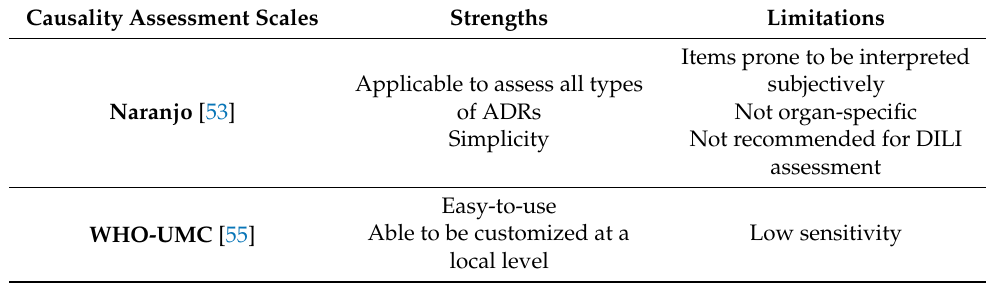
Table 2. Strengths and limitations of the causality scales used in the assessment of DILI associated with